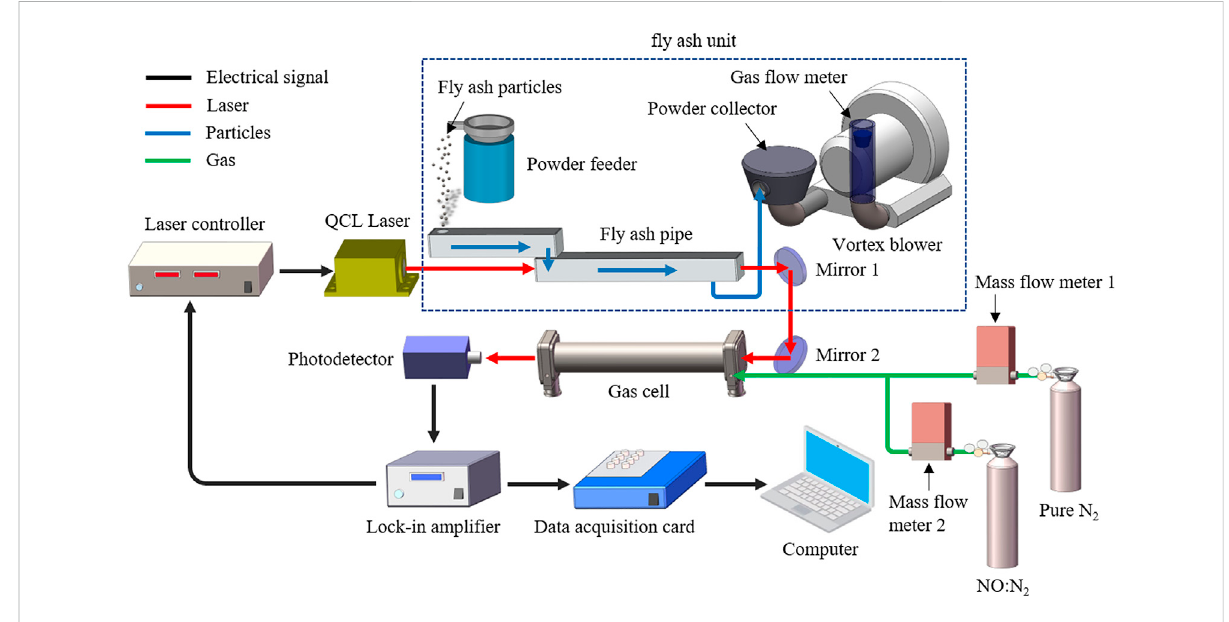
FIGURE 3 Schema of the experimental